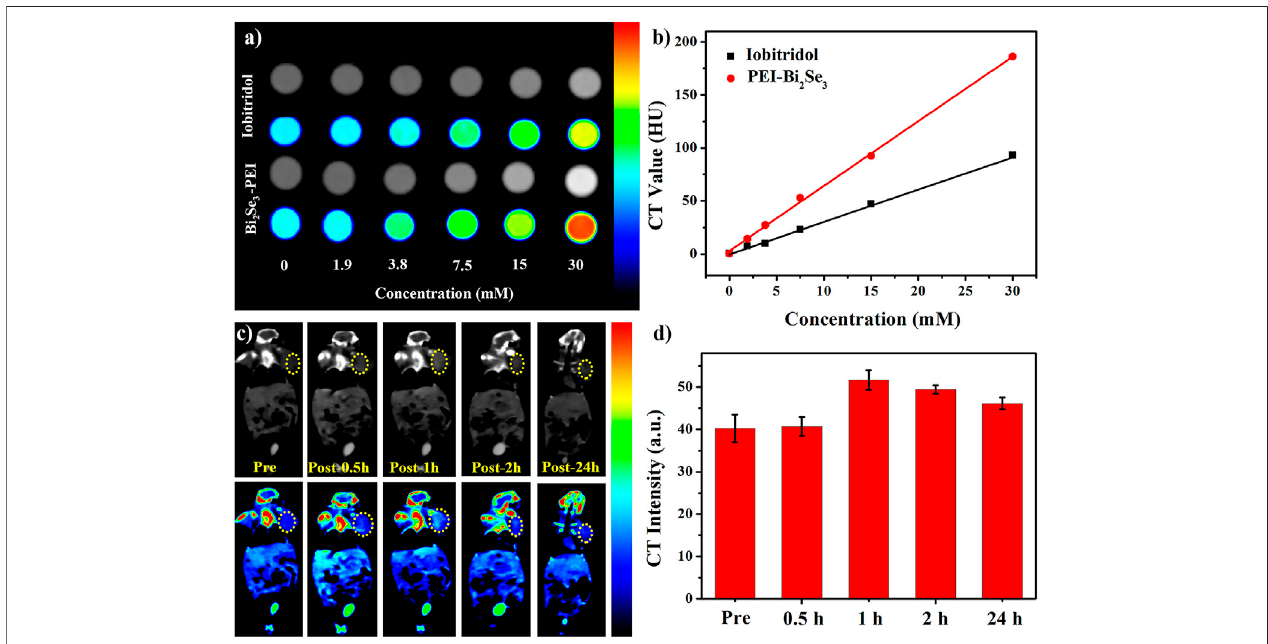
FIGURE4|(A) Invitro CTimagesofiobitridolandPEI-Bi 2 Se 3 nanodotsatdifferentconcentrations. (B) Concentration-dependentCTsignalsofiobitridol(blackline) and PEI-Bi 2 Se 3 nanodots(redline) invitro . (C) Time-dependentCTimagingoftumor-bearing micebeforeandafter intravenous injectionofPEI-Bi 2 Se 3 nanodots. (D) CT signal intensities of the tumor area at different